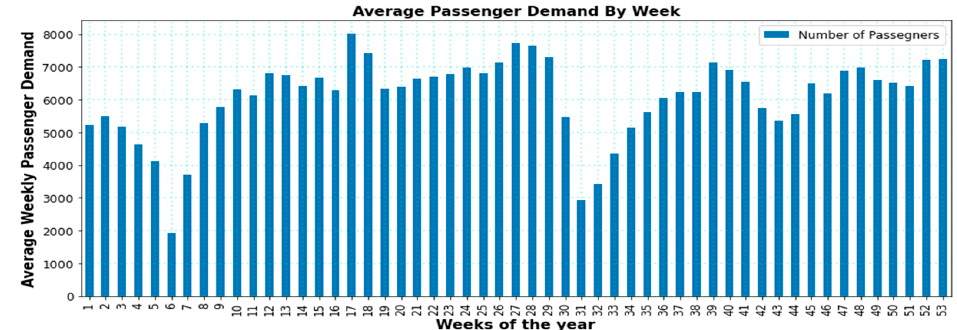
Figure 14. Passenger demand by weeks of the year.